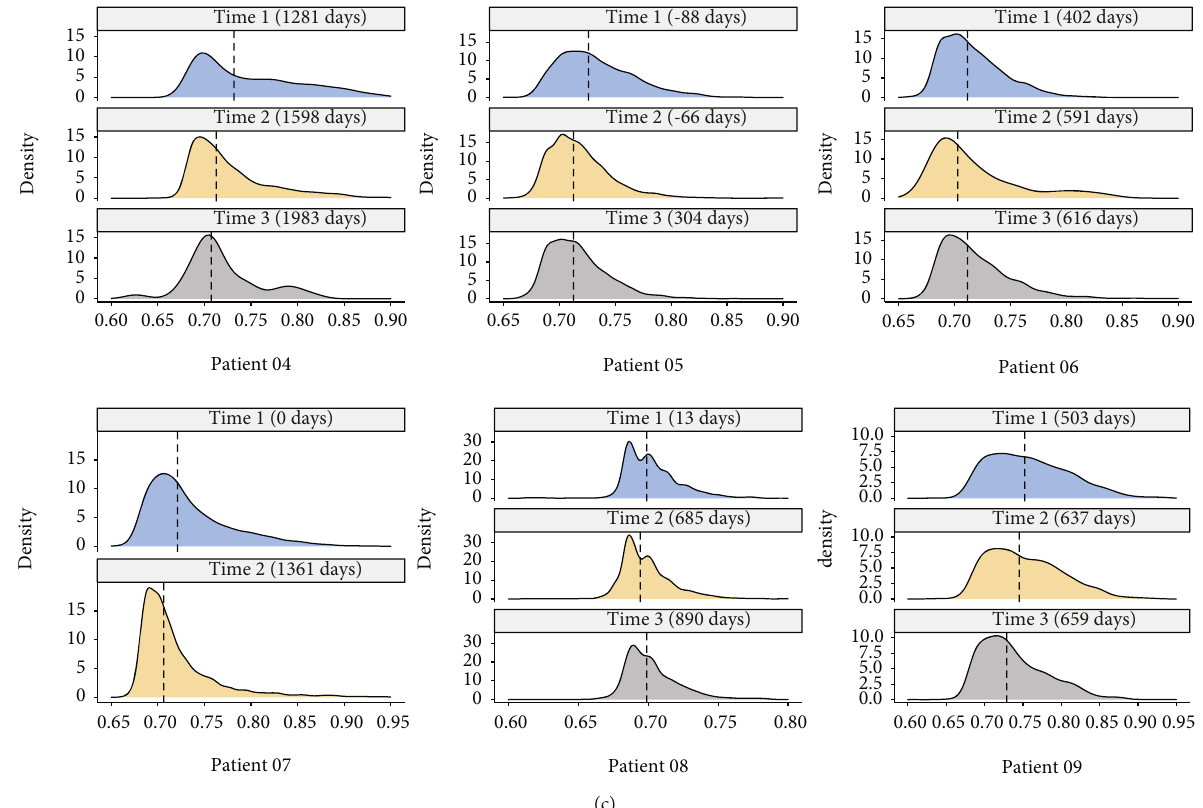
Figure 5: The association of cisplatin response scores with resistant pathways. (a) The correlation matrix between cisplatin response scores and the expression levels of genes in BAD apoptosis, ECM, and EMT pathways. The red and green colors indicated positive and negative correlations. The circle size represented the correlation coe ffi cient. Cscore: cisplatin response score. (b) The correlation of cisplatin response scores with the expression values of BAD, TGFB, and TWIST1. (c) The density of cisplatin response scores between the cells of three time points in six patients. The x -axis was the cisplatin response scores, and the dashed line showed the median response